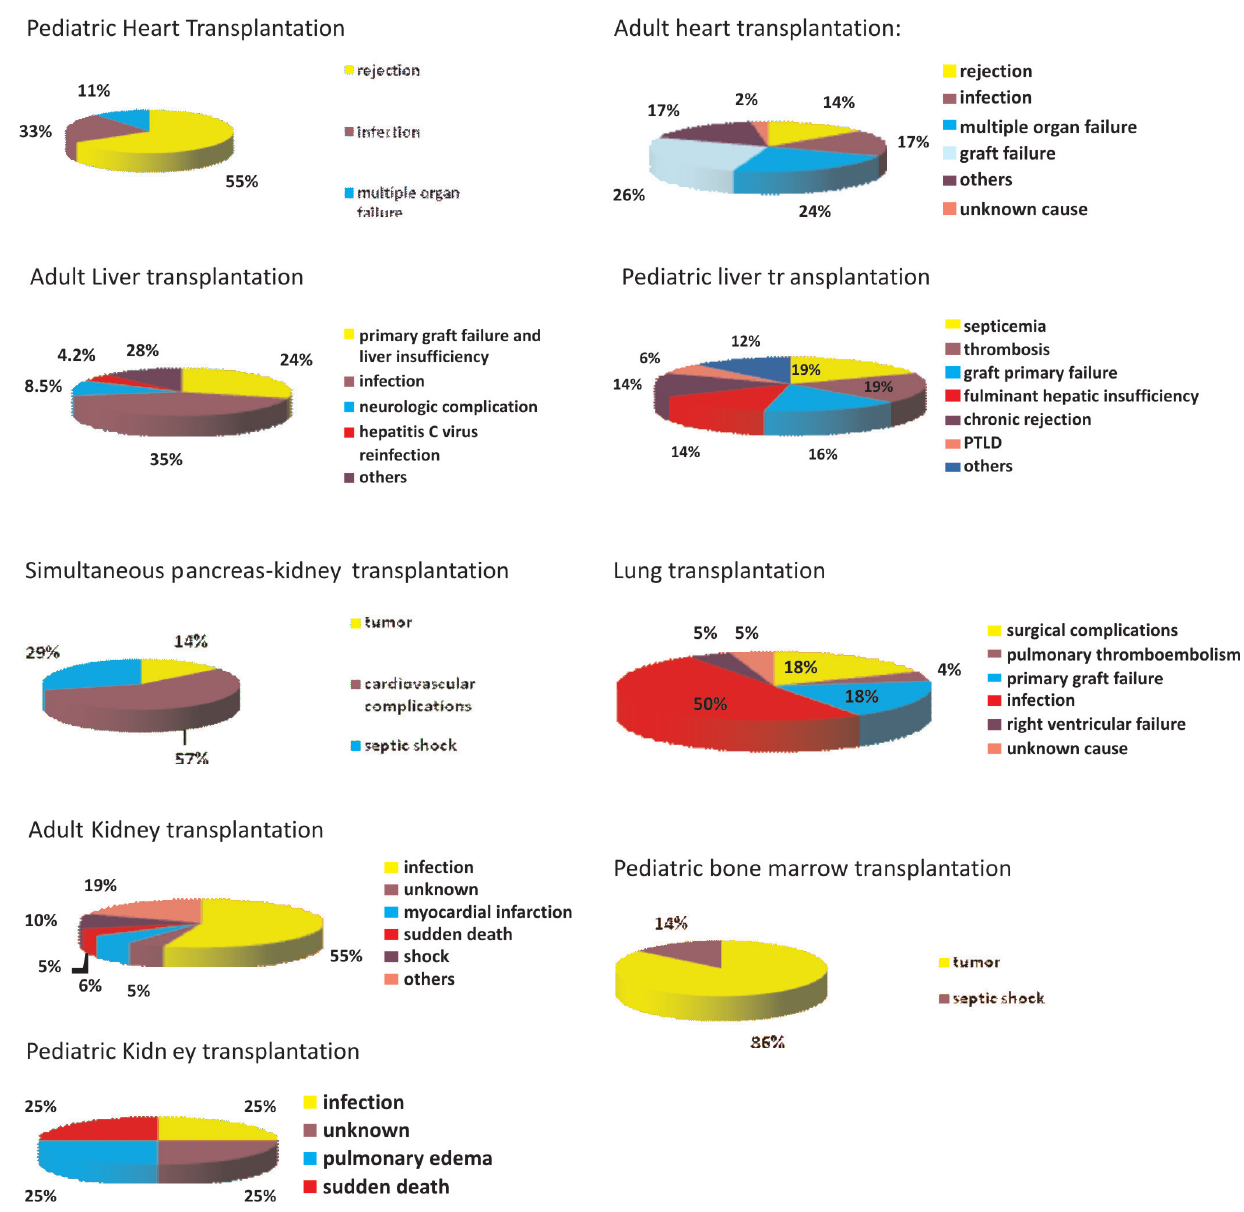
Figure 2 - Causes of mortality (2002 to 2007)